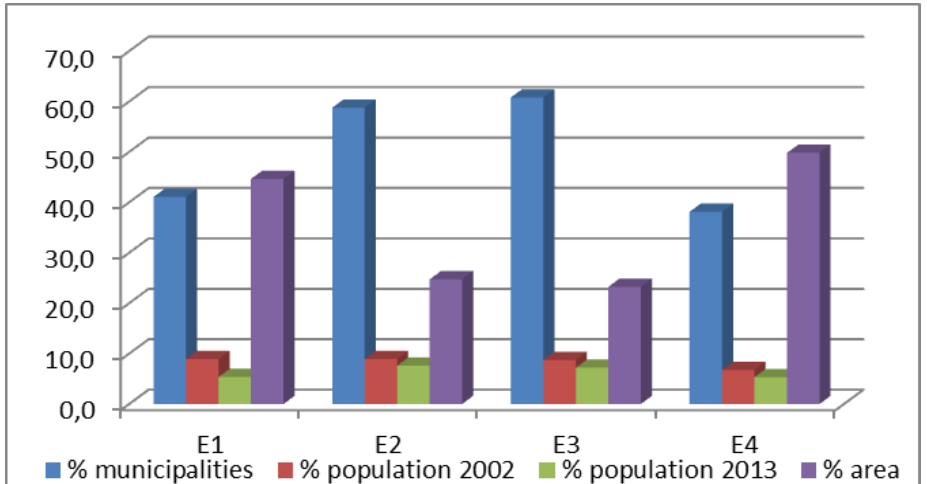
Fig. 5. Distribution of municipalities, population and area according migration intensity, I subtypes, Emigration type (calculated by the authors, according to SSORM